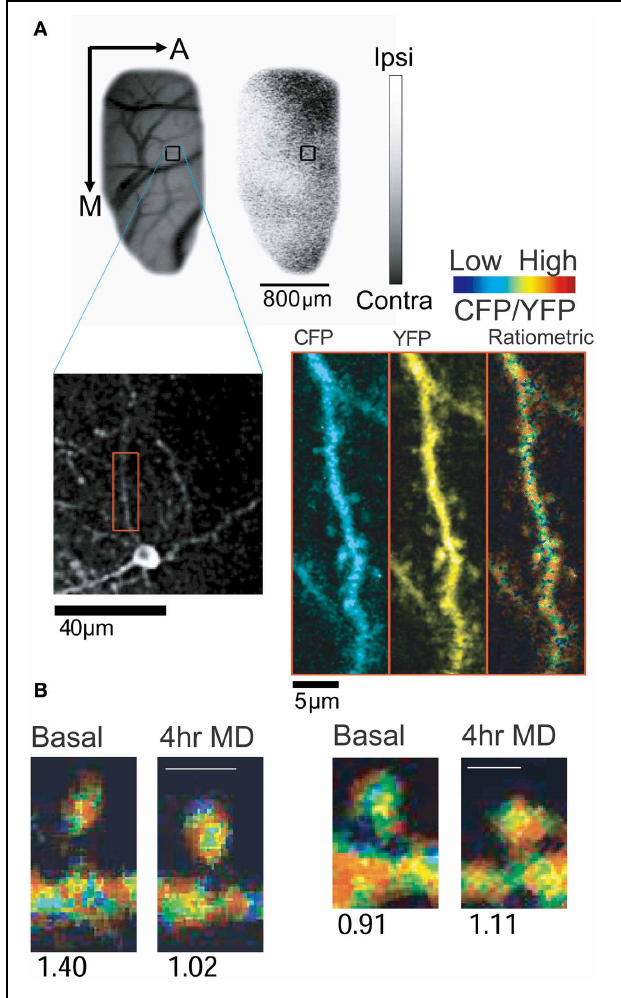
FIGURE 2 | In vivo imaging of CaMKII activity using Camui. (A) Expression of Camui in ferret visual cortex allowed for visualization of CaMKII activity in dendrites and spines of a neuron in a specific ocular dominance (OD) domain. Blood vessel and OD maps were acquired using intrinsic signal optical imaging ( Upper panel : A, anterior; M, medial). Gray scale indicates ocular dominance index (white, ipsilateral eye dominated; black, contralateral eye dominated). Blood vessels map and the low magnification two-photon microscopic image were cross referenced to identify the two-photon images ( Lower panel ) in a given OD map. A dendritic segment (red box) is magnified ( Right ) and displayed as channel separated images (CFP and YFP) as well as a ratiometric image in intensity-modulated display mode, indicating the CFP/YFP ratio. Warm hue represents high CaMKII activity. (B) Sample images of spines with decreased (left) or increased (right) CaMKII activity after 4h of monocular deprivation. Numbers below the images indicate the normalized CFP/YFP ratio, a measurement of FRET signal. From Mower et al.